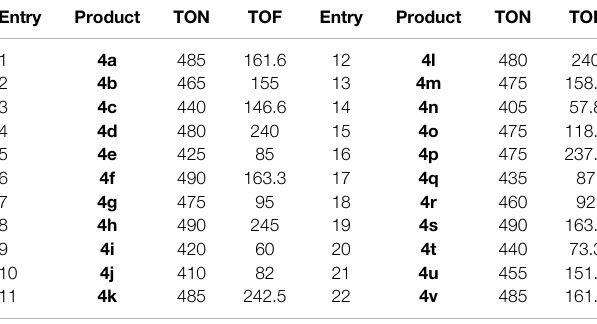
TABLE 4 | Calculated turnover number (TON) and turnover frequency